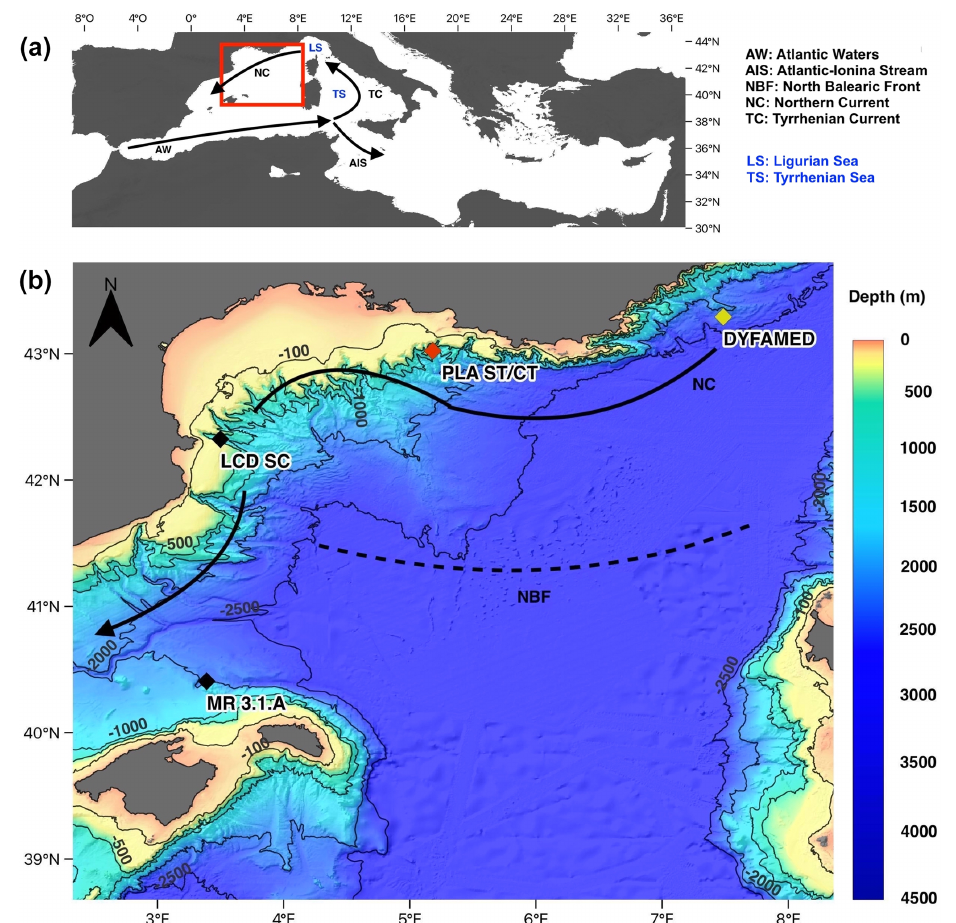
Figure 1. (a) Study area location in the Mediterranean Sea and general surface circulation (b) geographic setting of the Gulf of Lions and location of studied sites. Red diamond shows the position of the Planier site sediment trap and core top (PLA ST/CT). Black diamonds repre- sent the location of the seabed sediments samples analysed from Lacaze–Duthiers canyon (LCD SC) and Menorca promontory (MR 3.1A). Yellow diamond represents the location of the Dynamics of Atmospheric Fluxes in the MEDiterranean Sea (DYFAMED) site, located 200km upstream of Planier station position. Arrows represent the surface circulation (Millot, 1999). The topographic model was downloaded from the GEBCO database.